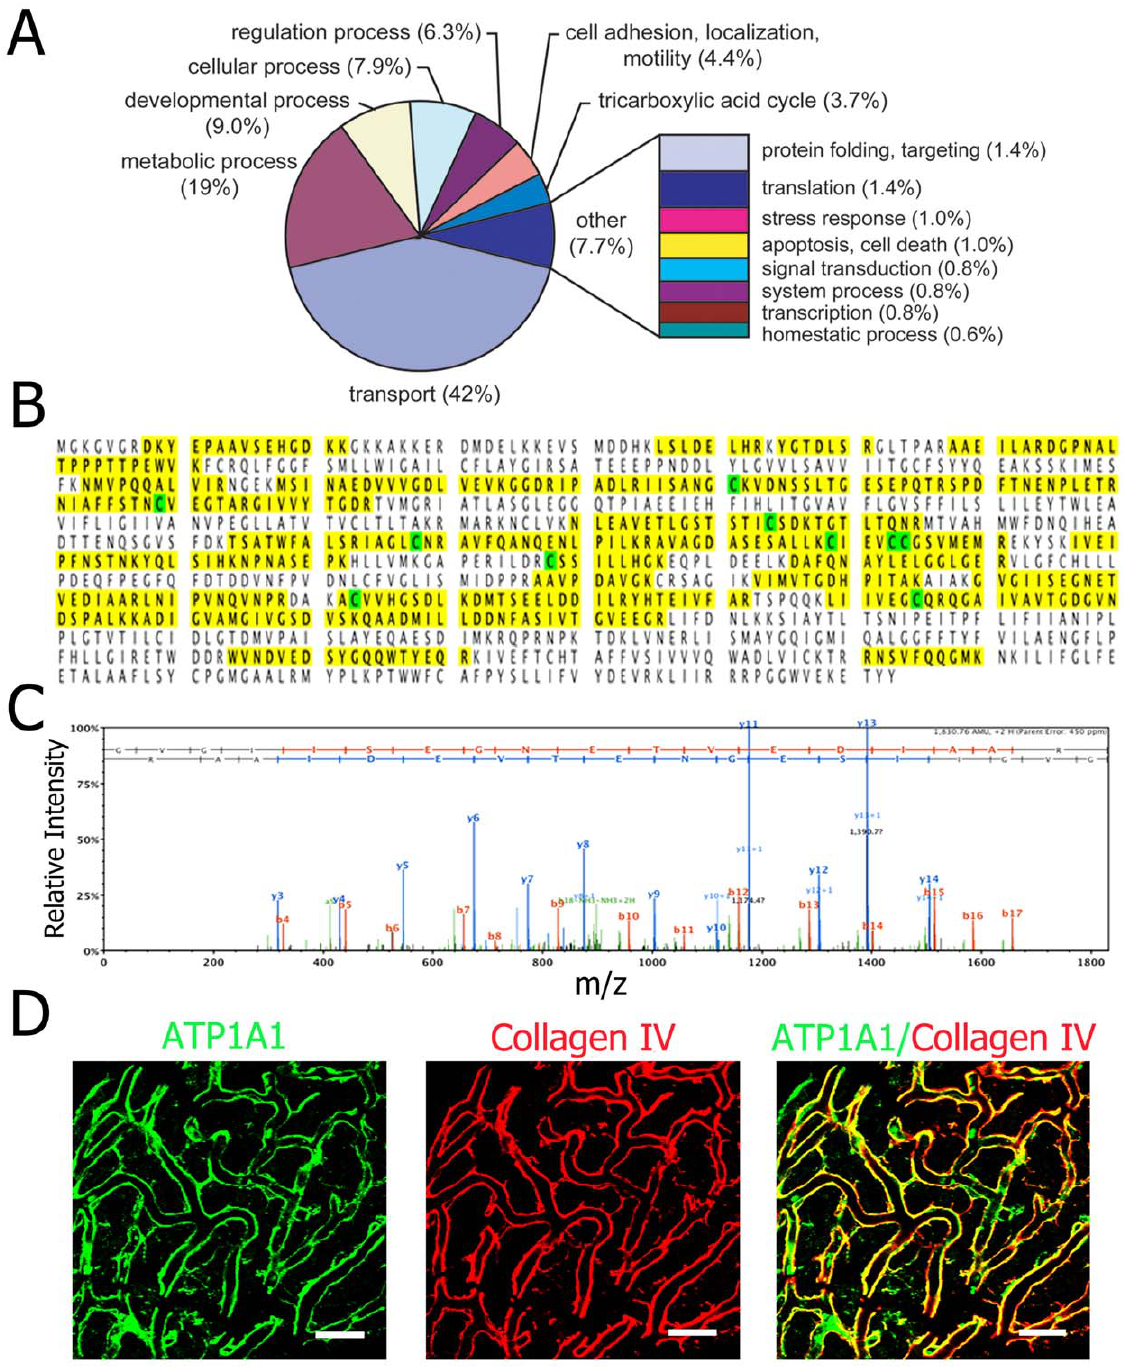
Figure 3. Classification of isolated stria vascularis capillary proteins identified ATP1A1 as the most abundant protein in the blood- labyrinth barrier. A , Spectral count-weighted tabulation of GO annotation by biological process. Proteins involved in transport (42%) and metabolism (19%) are highly expressed in the blood-labyrinth barrier. B , The sequence of ATP1A1 covered by identified peptides is outlined in yellow (45% coverage). The alkylated residues (green) were identified by iodoacetamide treatment. C , A representative MS/MS spectrum for peptide 630– 645 of ATP1A1. Graphically displayed are the fragment ions identified by SEQUEST from the tandem mass spectrometry data. Mass-to-charge (m/z) values are indicated next to each peak, along with positions of y-ions (blue) and b-ions (red). Unmatched ions are displayed as black. D , Localization of ATP1A1 (green) in stria vascularis capillaries (red, antibody for collagen type IV). A merged image (Right) shows the distribution of ATP1A1 along the capillary. Data in all panels are representative of at least 3 separate experiments. (Scale bars: D , 20 m m).